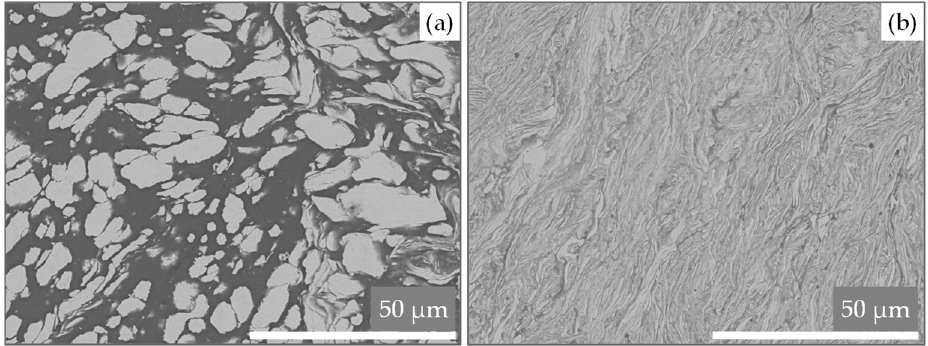
Figure 7. SEM images used for the evaluation of the sample with the lowest (( a ), experiment no. 10) and the highest (( b ), experiment no. 34) mean NOP.